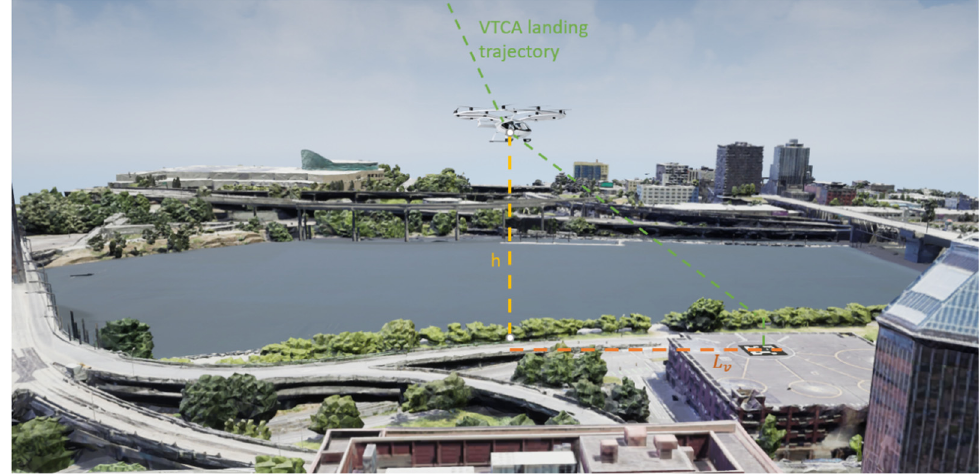
Figure 2. Scheme of the defined parameters used to compute the required VFOV in the last holding circle of the VTCA landing trajectory (not in scale).